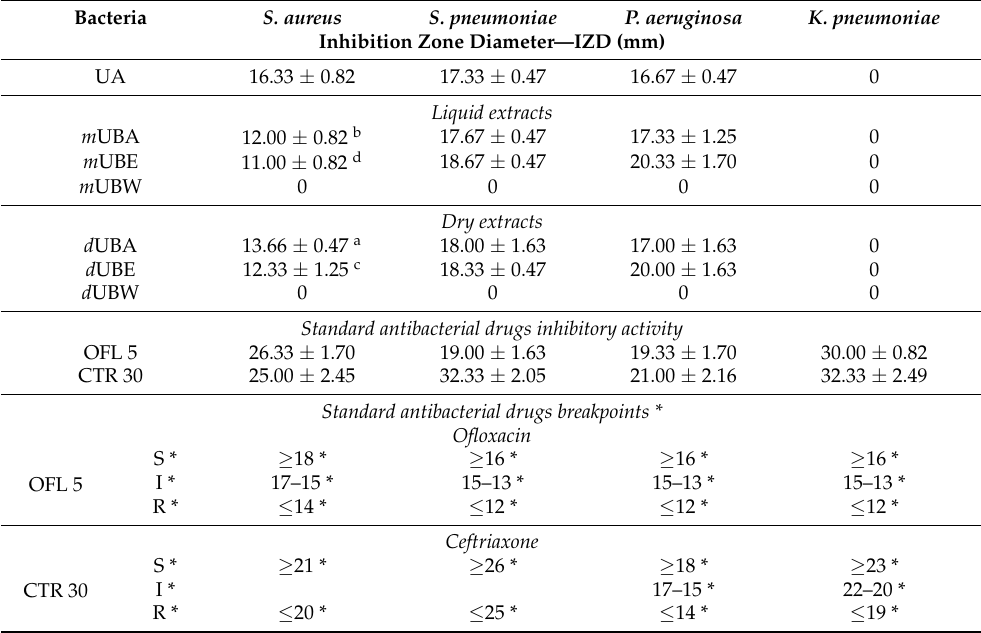
Table 5. Antibacterial activity of U. barbata extracts.